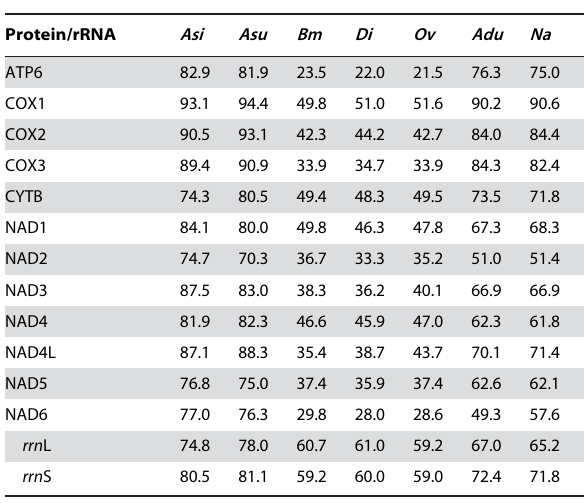
Table 2. Percentage of similarity in the amino acid sequences inferred from the 12 protein-coding genes and in the nucleotide sequence of each of the two ribosomal genes ( rrn L and rrn S) upon pairwise comparison between Toxocara canis and seven other parasitic nematodes (representing the orders Ascaridida, Spirurida and